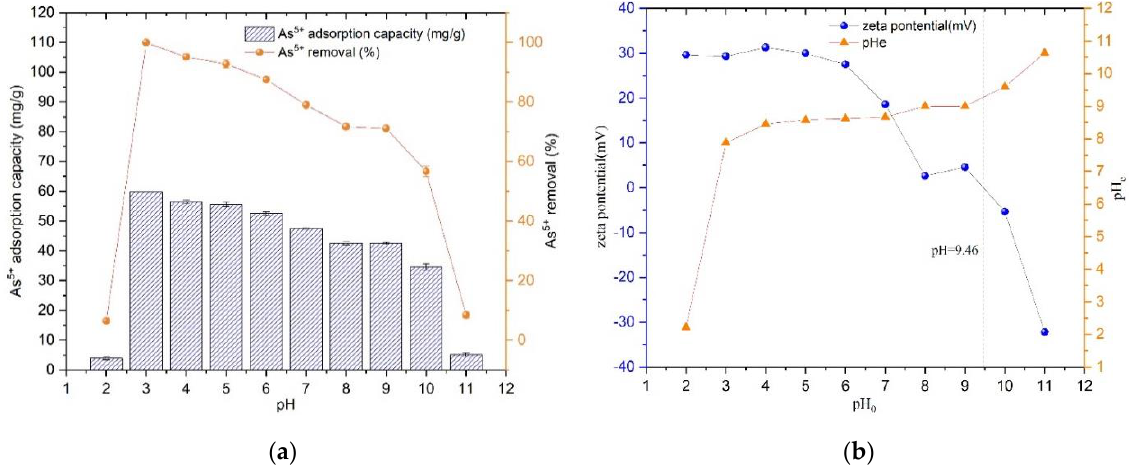
Figure 2. ( a ) The adsorption effect of pH; ( b ) Isoelectric point of Fe 3 O 4 @ZIF-8.